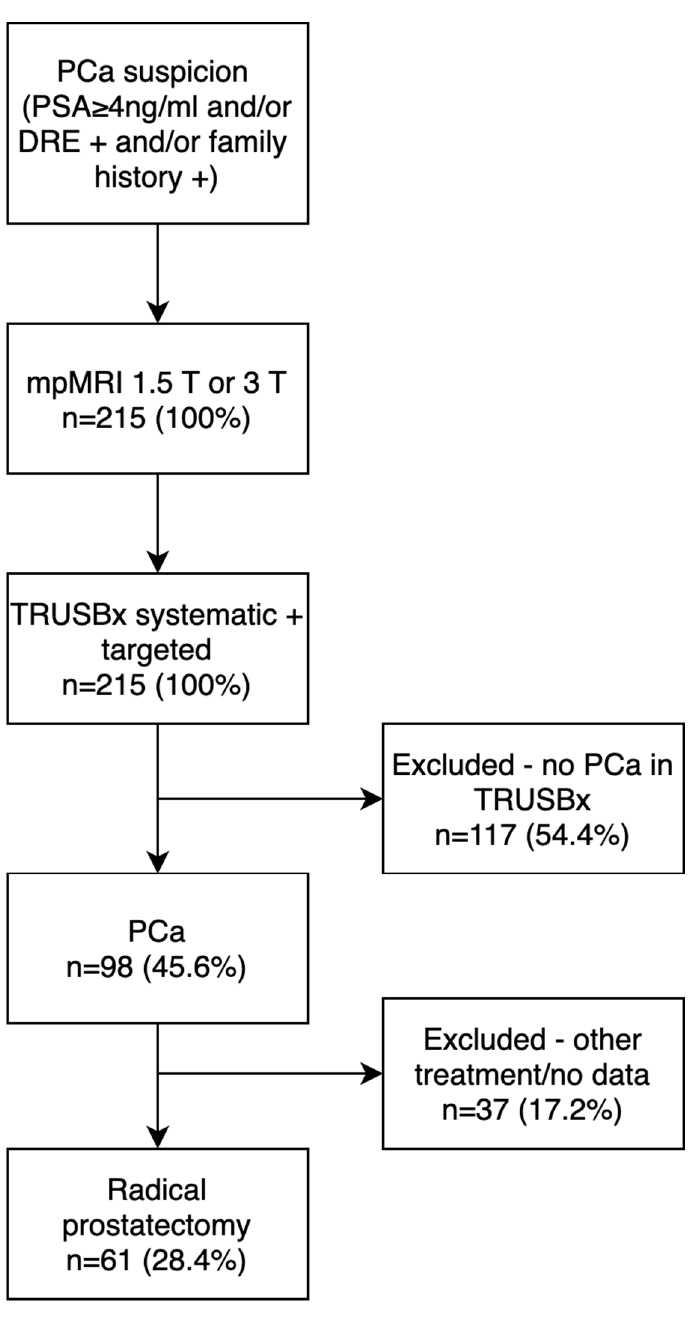
Figure 1. Flow chart of participant inclusion criteria. PCa—prostate cancer; DRE—digital rectal exam; PSA—prostate-specific antigen; mpMRI—multiparametric resonance imaging; TRUSBx—transrectal prostate biopsy.